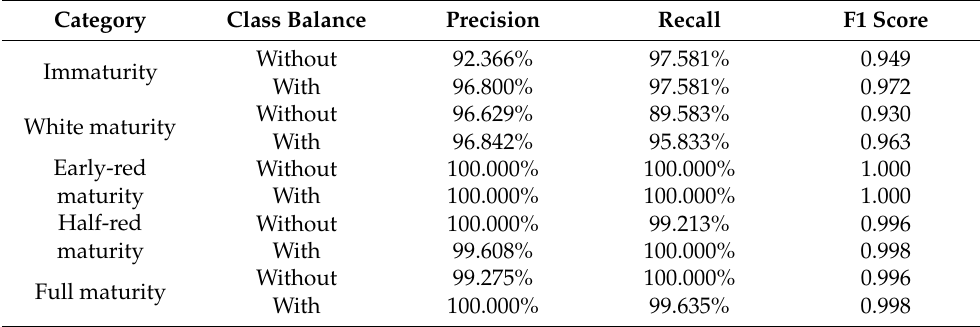
Table 4. Effect of class balance loss on validation